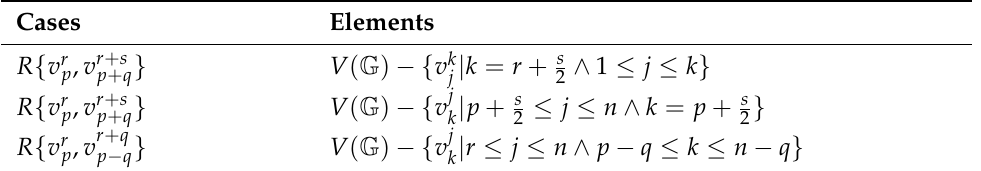
Table 5. ´ R u for 7 ≤ u ≤